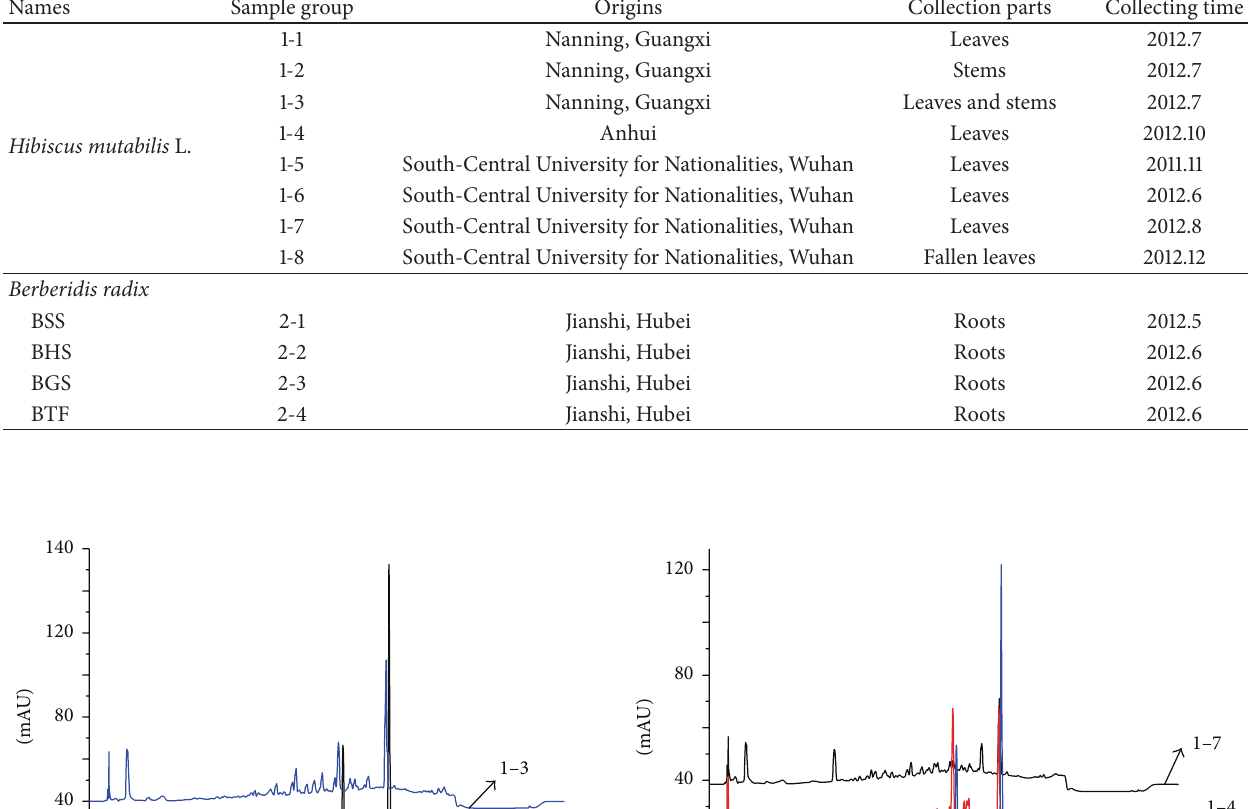
Table 1: A detailed list of all samples information of Hibiscus mutabilis L. and different species of Berberidis radix .